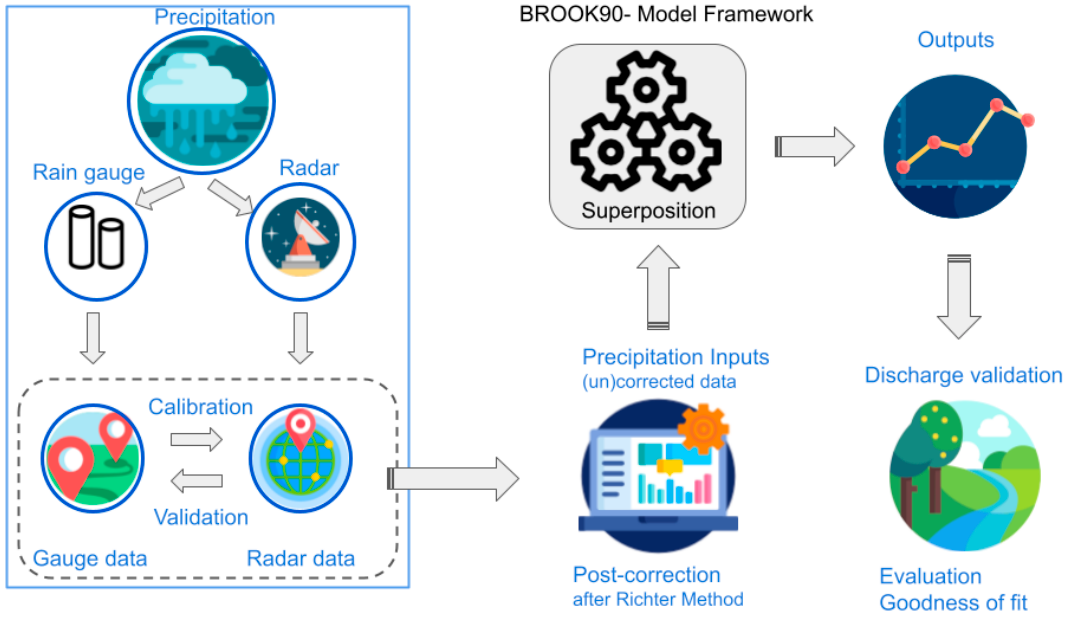
Figure 5. Principal scheme of the validation process.